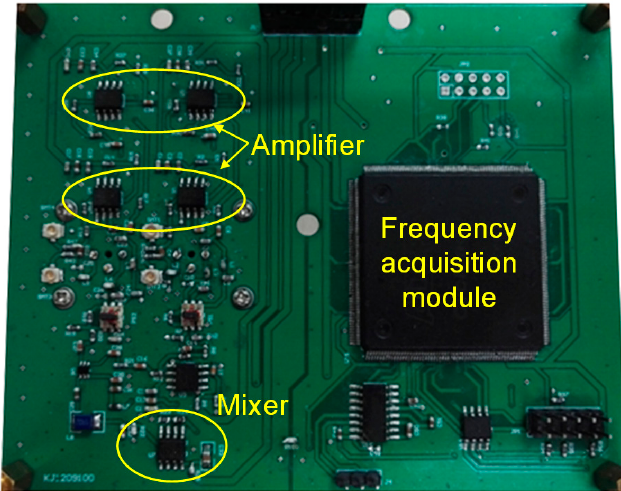
Figure 3. The oscillation PCB for methane gas sensor.